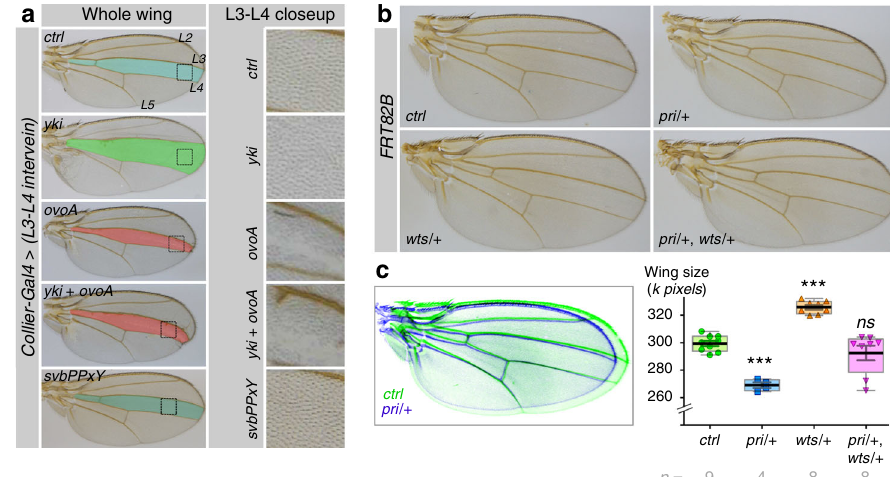
Fig. 8 Svb/Pri functionally interact with Yki in adult wings. a Adult wings expressing the indicated transgenes under the control of col-Gal4 , a driver active in the L3 – L4 region. b Genetic interaction between pri S18.1 and wts X1 alleles. c Overlay between control (green) and pri − / + (blue) wings (left), and quanti fi cation of wing area in the different conditions (right). Values are presented as average ± standard error of the mean (SEM) and boxes with whiskers (10 – 90 percentile). p -Values from Mann – Whitney tests are pri / + (<0.0001), wts / + (<0.0001), pri / + , wts / + ( = 0.4234) (ns, p ≥ 0.05; ** p < 0.01; *** p <